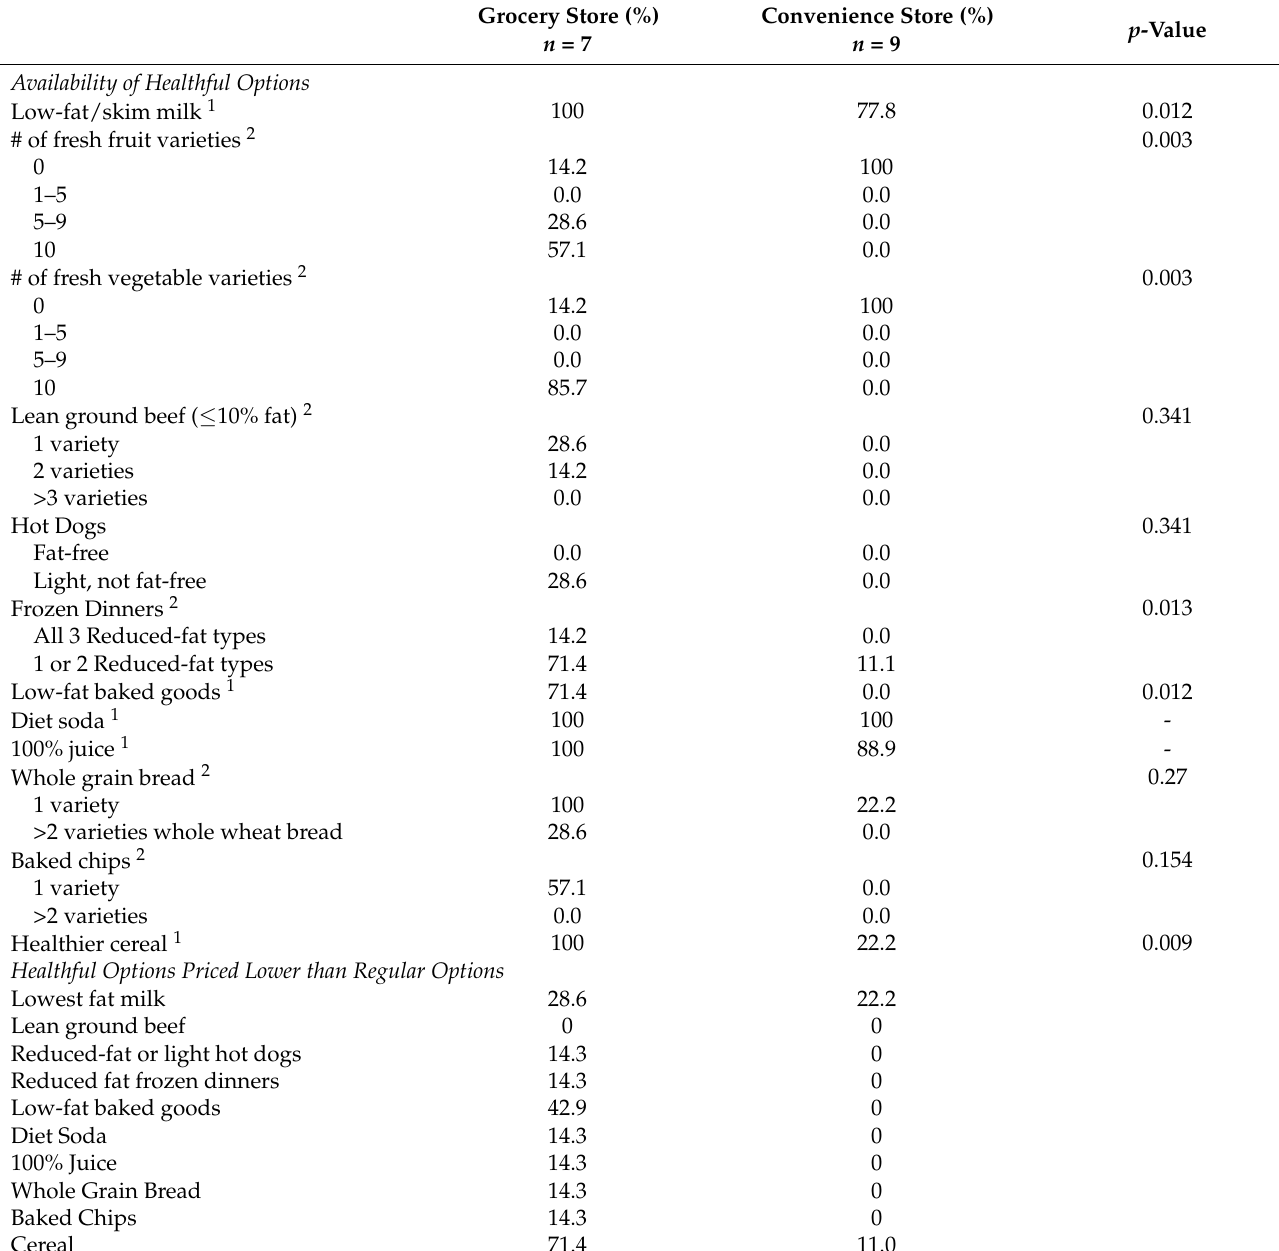
Table 2. Comparison of availability of healthful food options between grocery and convenience stores and pricing for healthful vs. regular food options in grocery stores and convenience stores